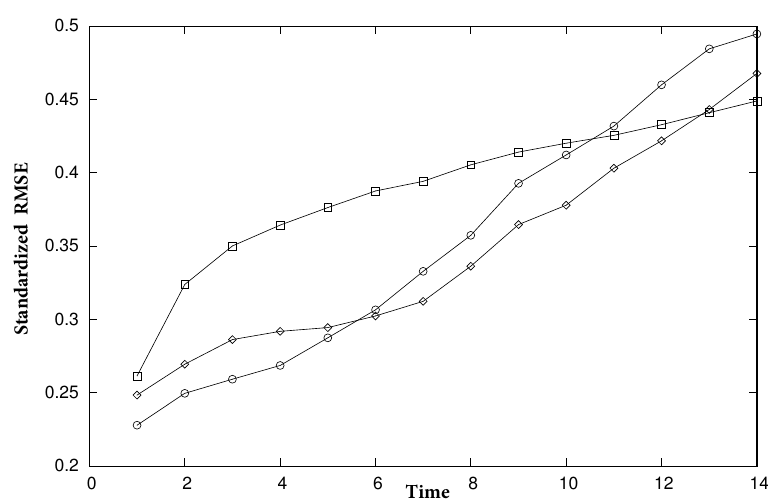
Figure 13. Prediction errors for coop2 using nonlinear